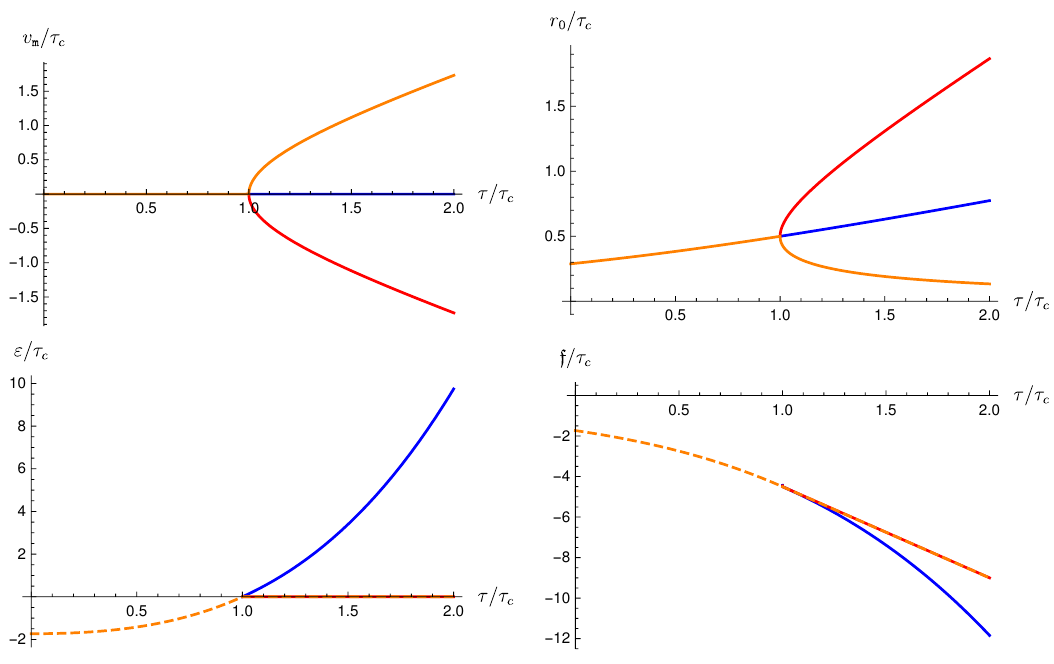
Figure 8 . Plot of the perturbative solutions (6.25) for B = 0 : 003 B c , together with the corresponding energy " and Helmholtz free energy f